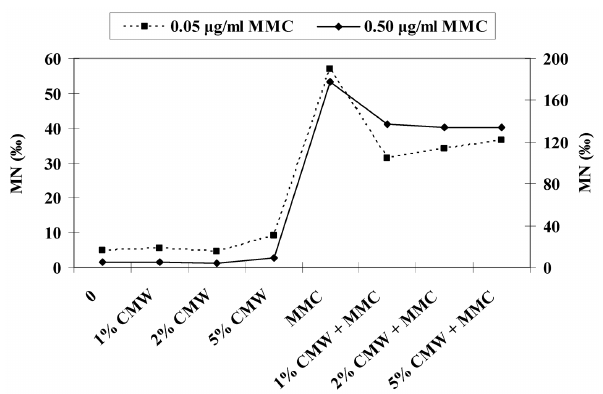
Figure 2. Comparative distribution of MN frequency ( % ) induced by CMW, MMC and their combination. The dotted line is read on the left hand Y-axis and the solid line on the right hand Y- axis.